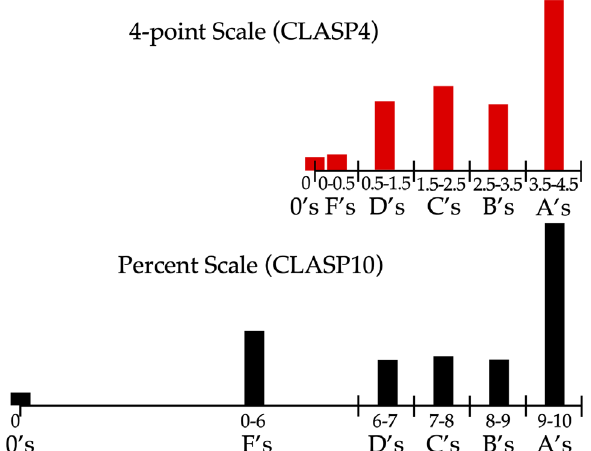
FIG. 3. The fractions of exam-item grades given under the two grade scales, CLASP4 and CLASP10, are shown. The nonzero F grades under CLASP10 are placed at the average value of these grades. Note that there are many more nonzero F grades given under CLASP10 and that the average F grade is lower than any F grade under CLASP4 so they carry a large weight when averaging and tend to skew the grade distribution